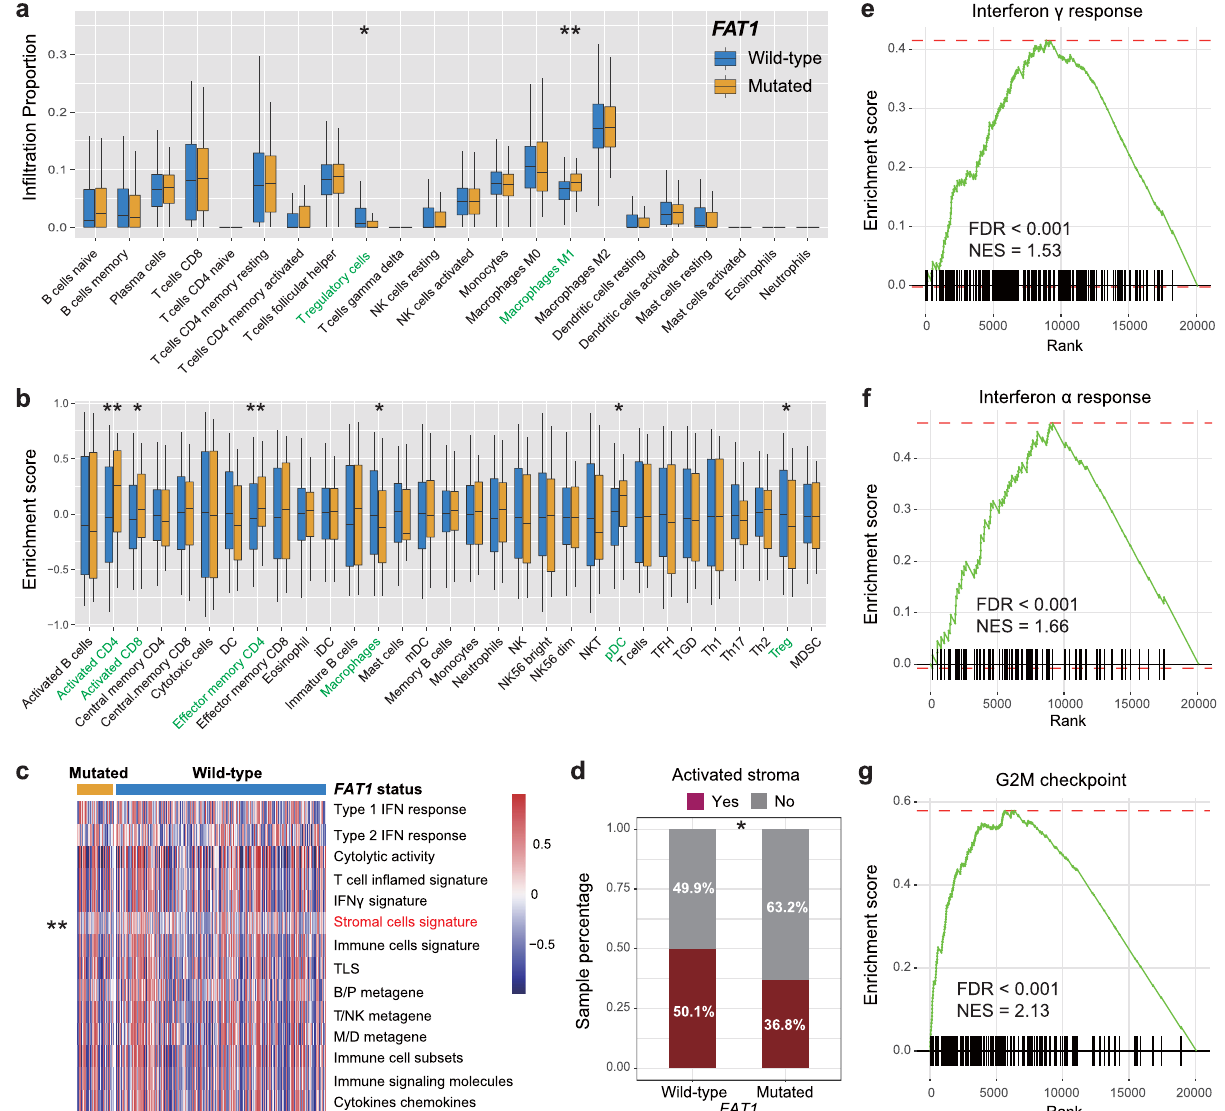
Fig. 7 Evaluation of immune in fi ltration, immune signatures, and pathway enrichment in FAT1 -mutated melanoma patients. Distinct immunocyte in fi ltration abundance in FAT1 mutated versus wild-type subgroups was assessed with a CIBERSORT and b Angelova et al. methods, respectively. Blue box, FAT1 wild-type patients; orange box, FAT1 -mutated patients; black scale bar, range of each immunocyte in fi ltration abundance. Signi fi cantly differentially in fi ltrating immunocytes between two subgroups were highlighted with green. c Heatmap representation of immune-related signatures enrichment in distinct FAT1 mutational subgroups. Signi fi cantly differentially enriched signature between two subgroups was highlighted with red. d Distinct proportion of activated-stroma subtype in distinct FAT1 mutational subgroups. e – g Signi fi cantly enriched signaling pathways in FAT1 -mutated melanoma patients. * P < 0.05, ** P <